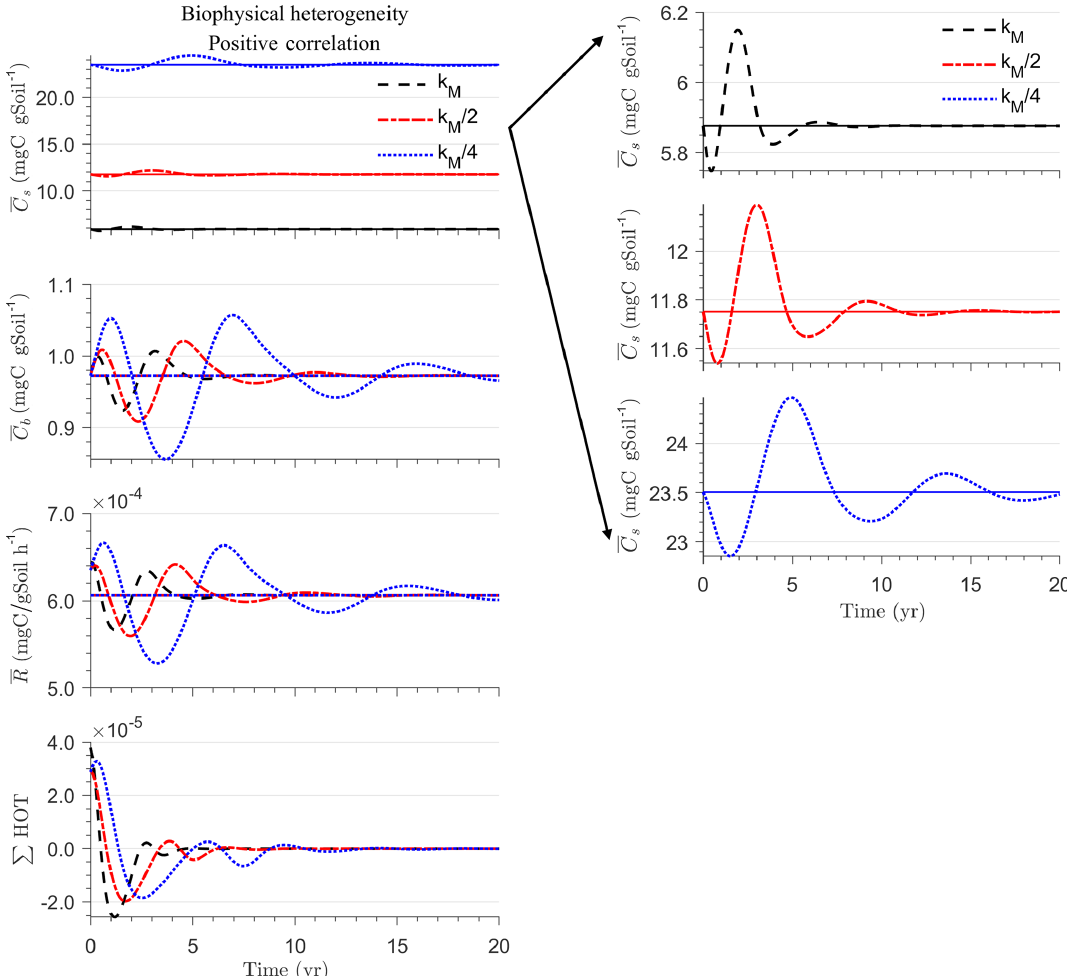
Figure A1. (a) Mean substrate C ( C s ), (b) mean microbial C ( C b ), (c) mean respiration rate ( R ), and (d) sum of second- and third-order terms ( (cid:80) HOT) are shown as a function of time for positively correlated initial spatial heterogeneity of C s and C b . This figure is similar to Fig. 4 (initial substrate is distributed randomly around the steady state). Varying levels of the rate constant k M are shown (as indicated by different line styles and colors; the base case is the same as in Fig. 4). Panels on the right are enlarged views of the time trajectories of C s .